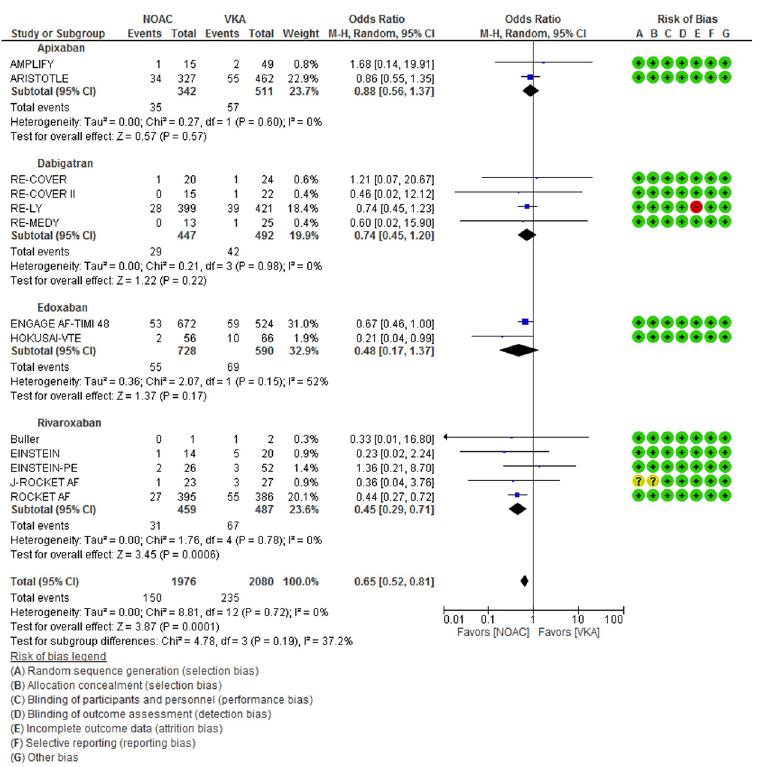
Fig 2. Relative Odds of Fatal Bleeding Given Occurrence of Major Bleed. Odds ratios and 95% confidence intervals are given for the relative odds that major bleeding events will lead to fatal bleeding events.